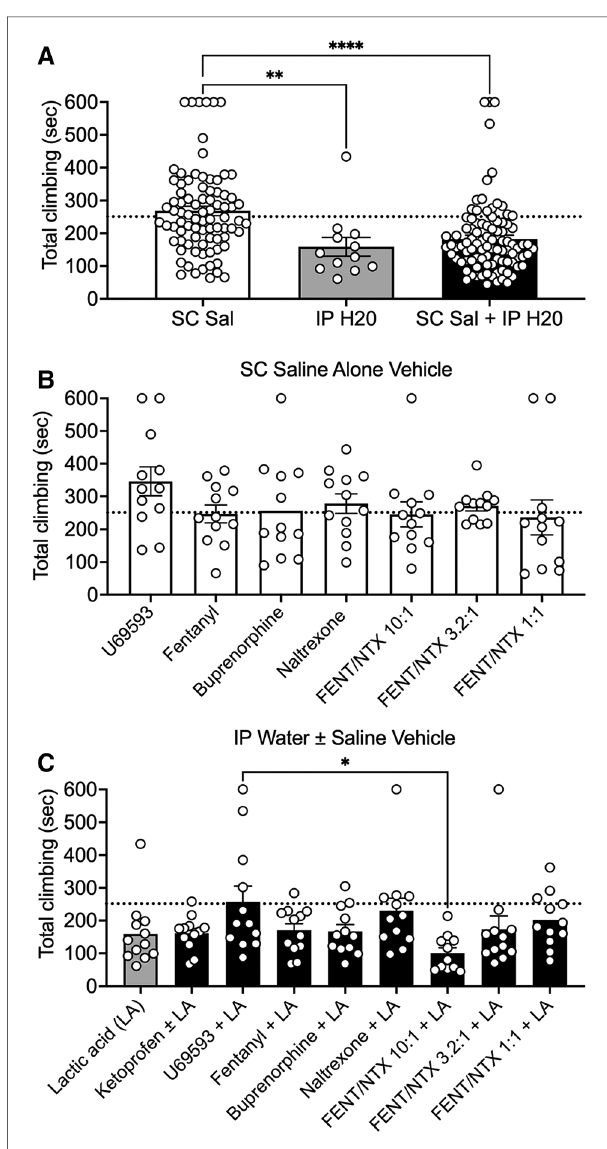
FIGURE 2 Effects of vehicle control conditions on climbing. ( A ) Comparison of climbing times for the three different types of vehicle condition. Abscissa: Type of vehicle treatment: SC Sal; N =84, IP H20; N =12, and SC Sal+IP H2O; N=95. ( B ) Comparison of climbing times for each group that received SC saline as the vehicle condition. Each group is identi fi ed by the drug or drug mixture tested in the group. ( C ) Comparison of climbing times for each group that received IP water alone or SC saline+IP water as the vehicle condition. Each group is identi fi ed by the drug or drug mixture tested as a pretreatment to IP lactic acid (LA) in the group. For all panels, the ordinate is total climbing time in sec, the dotted line shows the mean climbing time on day 1 by the “ No Treatment ” group shown in Figure 1 , bars show mean±SEM, and points show data for individual mice. Asterisks show a signi fi cant difference between groups as indicated by one-way ANOVA and Holm-Sidak post hoc test. * P < 0.05, ** P <0.01, **** P